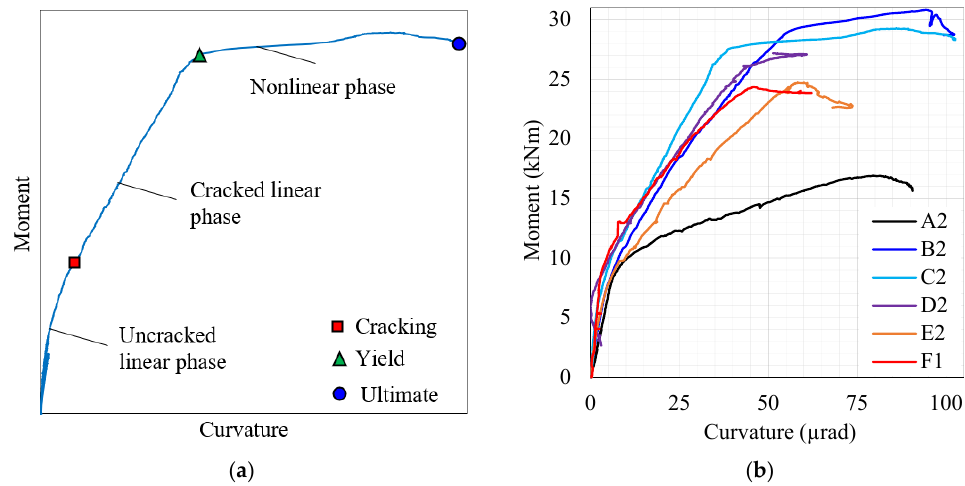
Figure 13. The moment–curvature: ( a ) typical curve and ( b ) comparison between different UHPC beams.